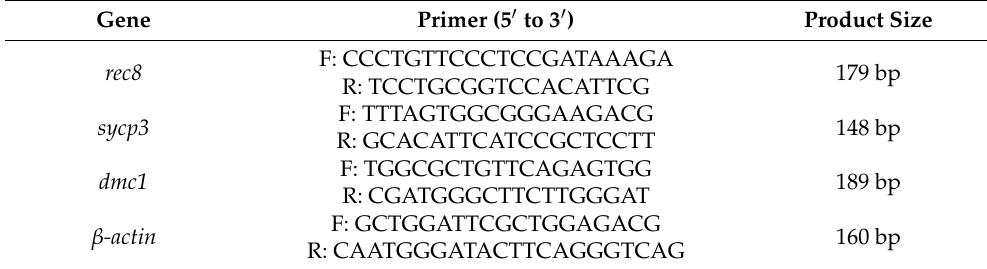
Table 3. RT-qPCR primers for examining meiotic marker genes’ expression in SG3